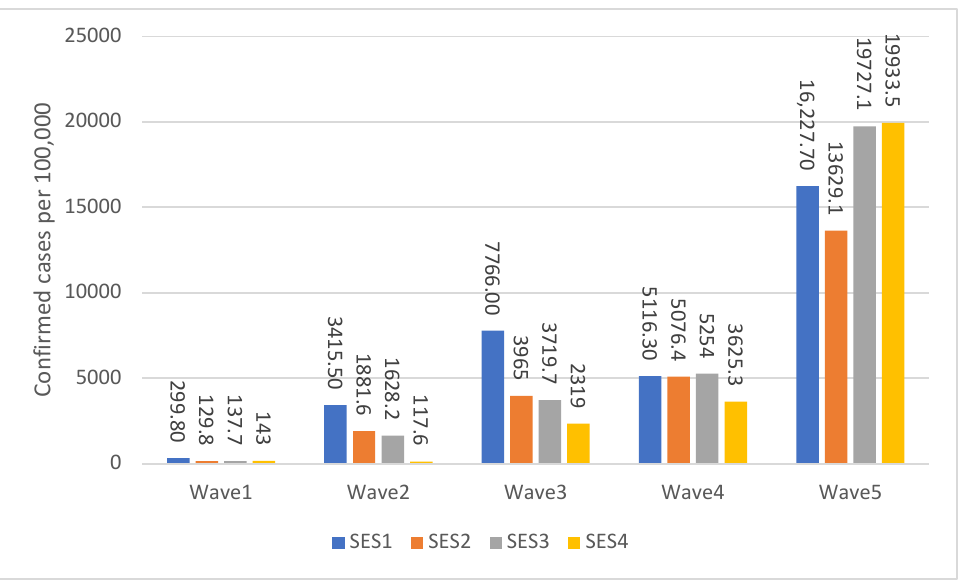
this was the case for cluster SE 1 (41.4 per 100,000). In wave 4, the highest percentage of mortality occurred for SE cluster 3 (26.8 per 100,000), while in wave 5, the highest mortality percentage was observed for cluster 2 (15.9 per 100,000). Note that cluster 4 is the smallest SES cluster in terms of the number of confirmed cases per cluster, so in absolute numbers, this relates to a small number of deaths.